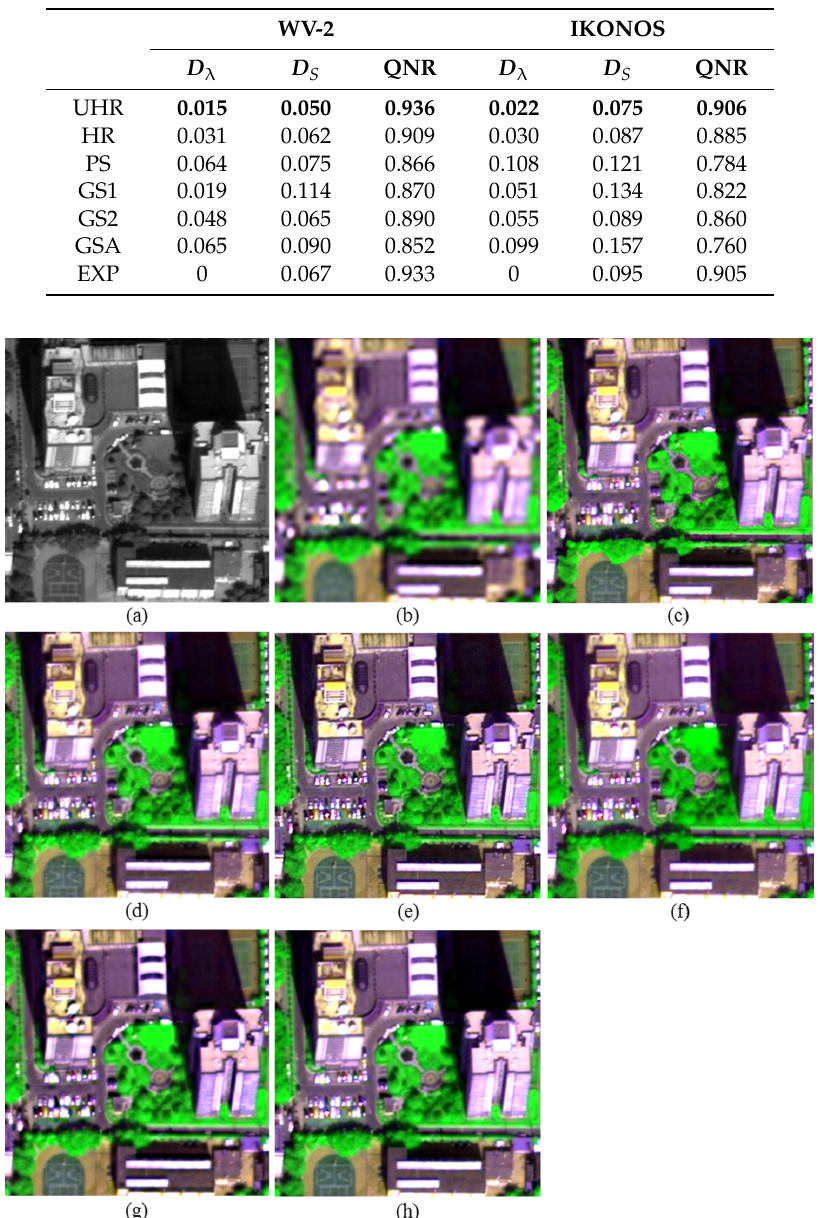
Figure 8. The 256 × 256 subsets of the MS and PAN images and the corresponding fused images produced from the original WV-2 dataset: ( a ) 0.5-m PAN image; ( b ) up-sampled version of the 2-m MS image; and the results of ( c ) UHR fusion, ( d ) HR fusion, ( e ) PS fusion, ( f ) GS1 fusion, ( g ) GS2 fusion and ( h ) GSA fusion.